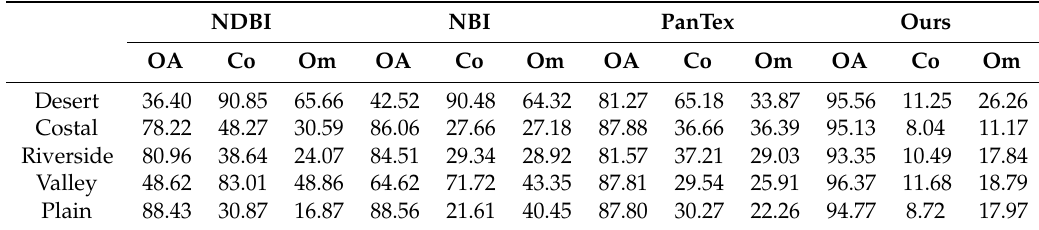
Figure 6. Comparison of the results of the four methods. ( a ) RGB images, ( b ) ground truth, ( c ) NDBI maps, ( d ) NBI maps, ( e ) PanTex maps, ( f ) our saliency maps, ( g ) built-up areas maps (NDBI), ( h ) built-up areas maps (NBI), ( i ) built-up areas maps (PanTex), ( j ) built-up areas maps (proposed method). Table 8. Accuracy assessment of the resultant images.